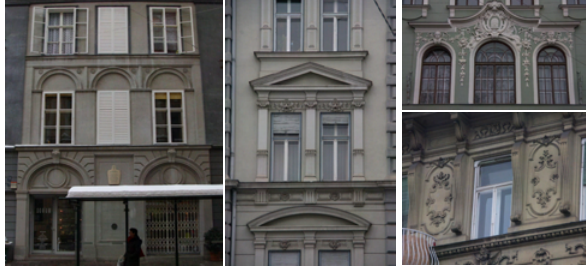
cacies of facade composition (left), vertical coherence (middle), and horizontal coherence (right) between ajacent